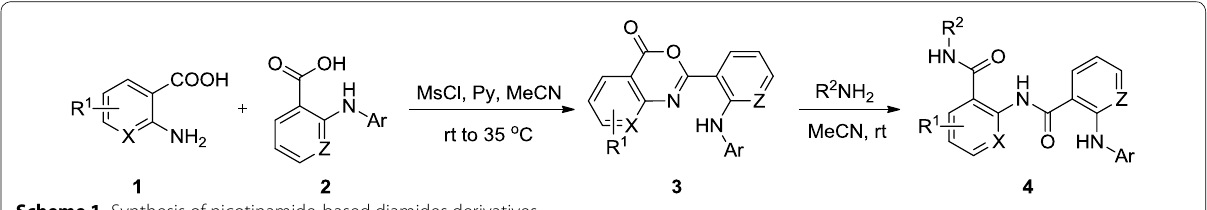
Scheme 1 Synthesis of nicotinamide-based diamides